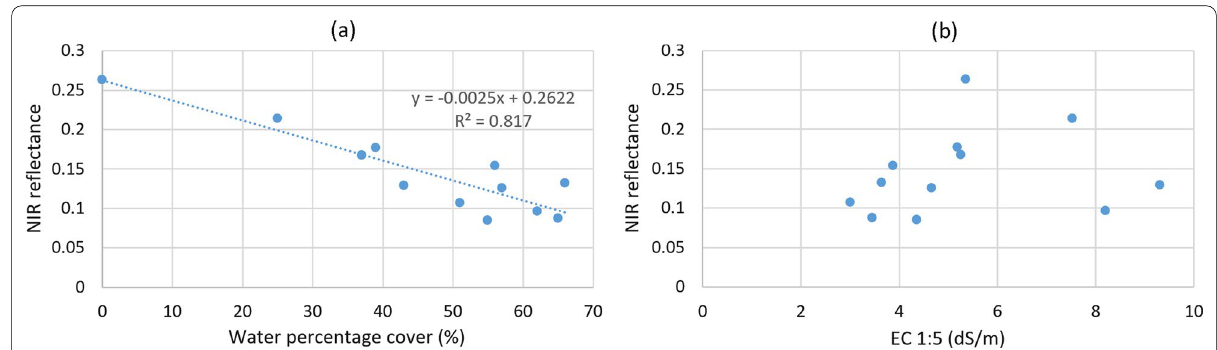
Fig. 2 Relationship of the L8 NIR reflectance of the G30–G41 pixels with a the water percentage cover and b the EC 1:5 provided by Nguyen et al.